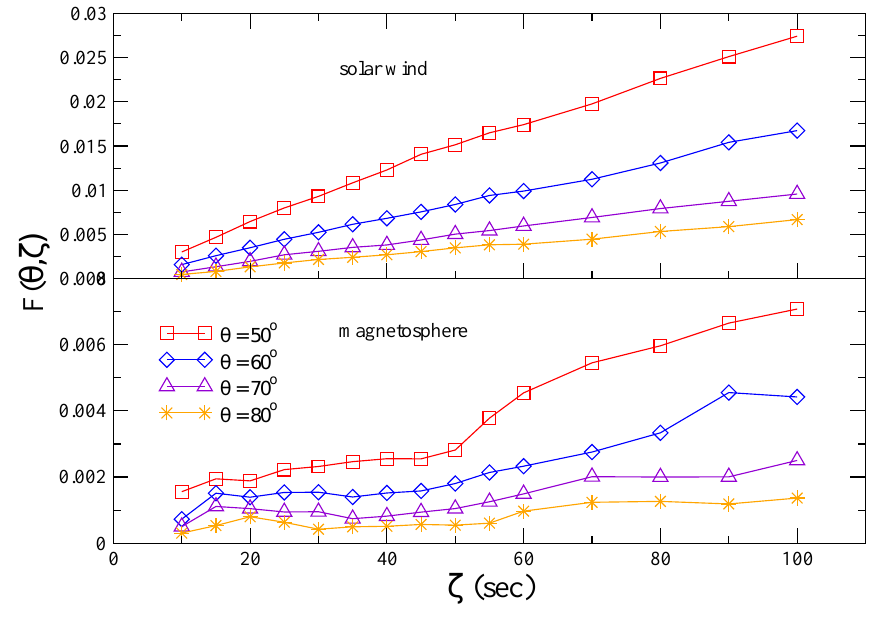
Fig. 3. ζ dependence of F(θ,ζ) . The upper panel is for period A and the lower panel for period B. X-axis is ζ and y-axis is F(θ,ζ) . In both panels, four θ values are considered. See text for